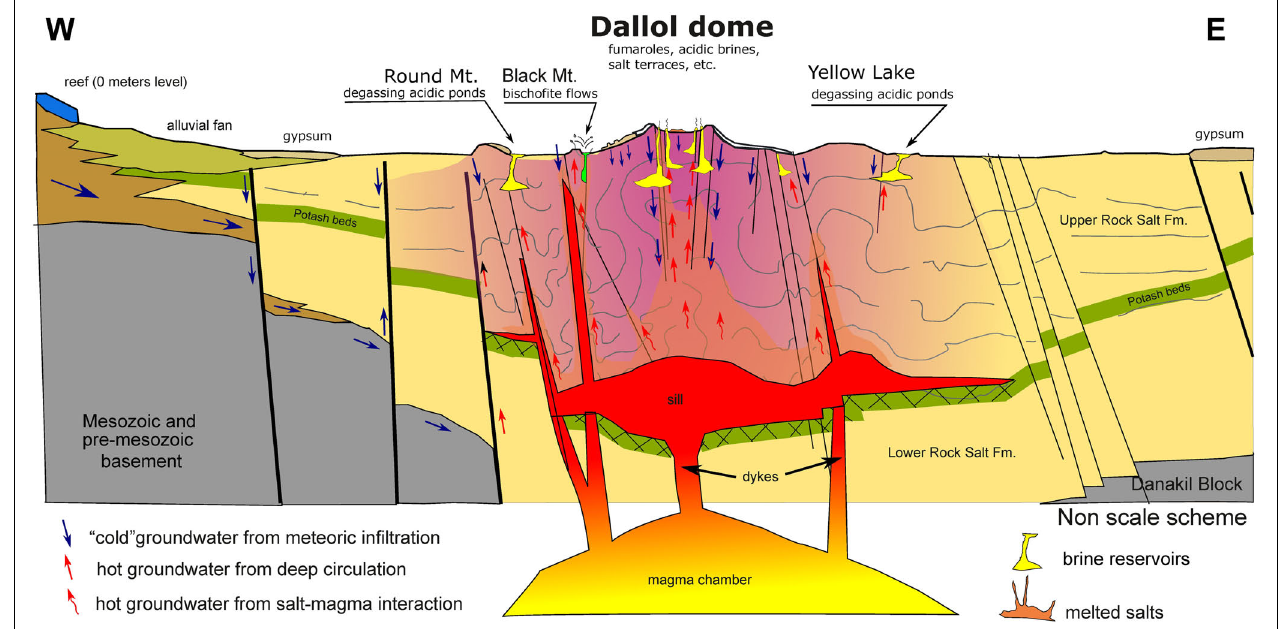
FIGURE 14 | Idealized conceptualization of the hydrogeothermal system of the dome of Dallol.